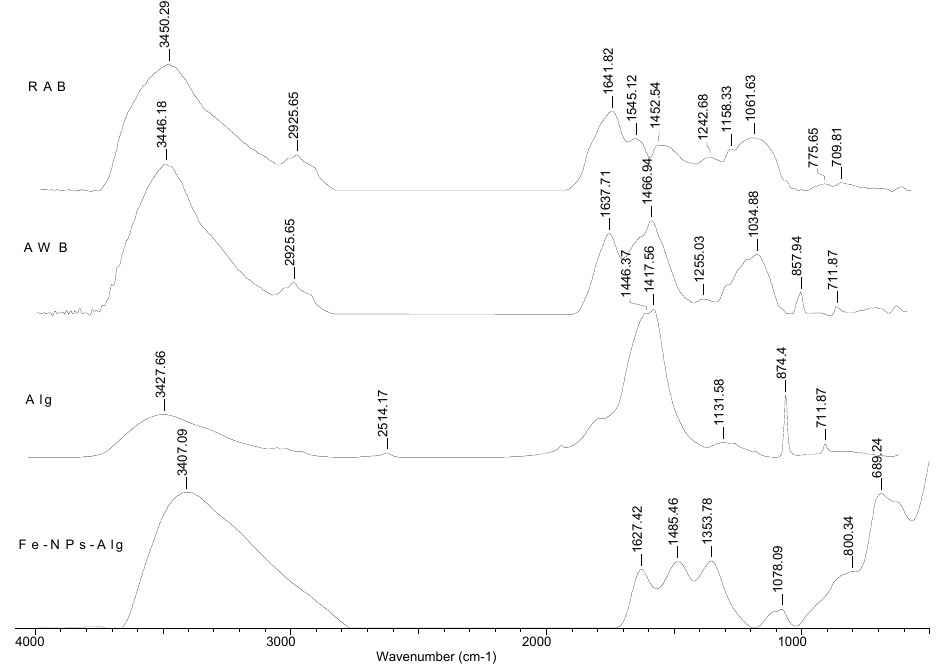
Figure 1. FTIR spectra of studied adsorbent materials.